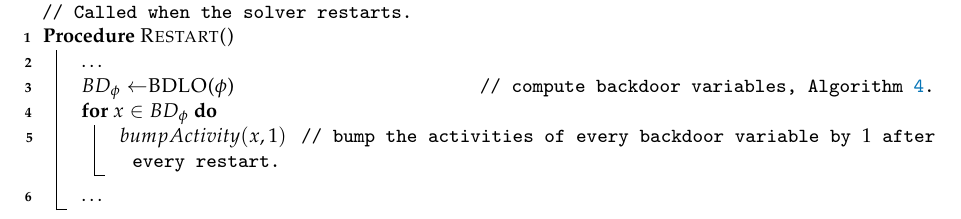
Algorithm 10: VSIDS_BDsize_restart a variant of the VSIDS decision heuristic.